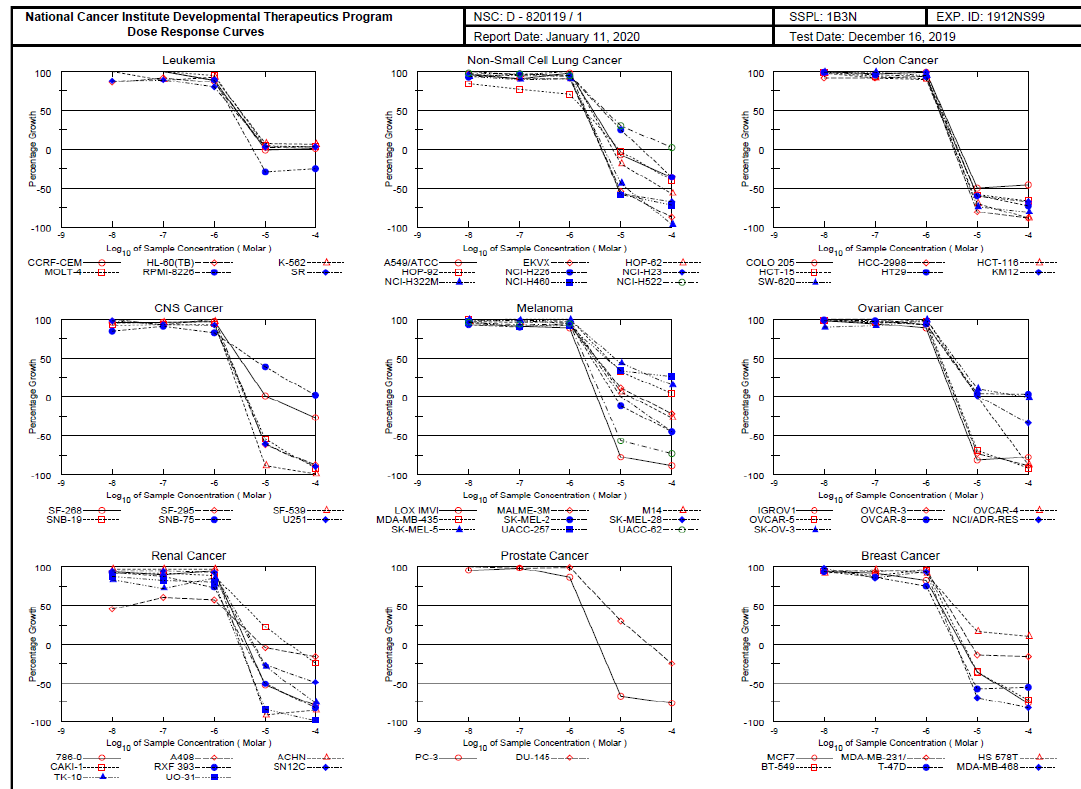
Figure 9. Dose–response curves of compound 3a (log 10 of sample concentrations 0.01, 0.1, 1, 10, and 100 μM) against all nine different cancer cell line panels (leukemia, non-small-cell lung, colon, CNS, melanoma, ovarian, renal, prostate, and breast cancers).